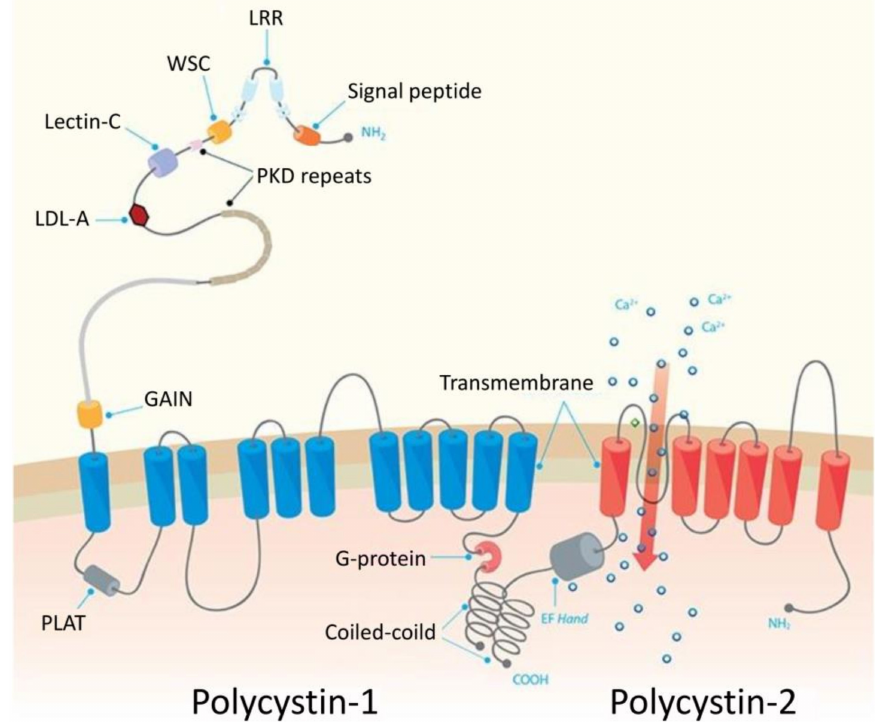
Figure 2. The structure of polycystins. LRR: leucine-rich repeats; WSC: cell wall integrity and stress response component domain; Lectin C: lectin C type-3 domain; LDL-A: low-density lipoprotein-A domain, PKD: polycystic kidney disease repeats; GAIN: G-protein-coupled receptor (GPCR) autoproteolysis-inducing domain, PLAT: Polycystin-1, Lipoxygenase, Alpha-Toxin domain. The Figure reprinted and modified with permission from [45] under Creative Commons Attribution 4.0 International (CC BY